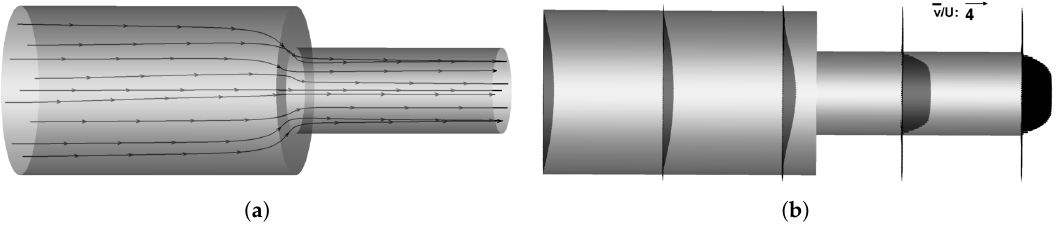
Figure 7. Flow visualization in the 3D domain at Re D = 365. ( a ) Streamline for different positions and ( b ) velocity vector for different